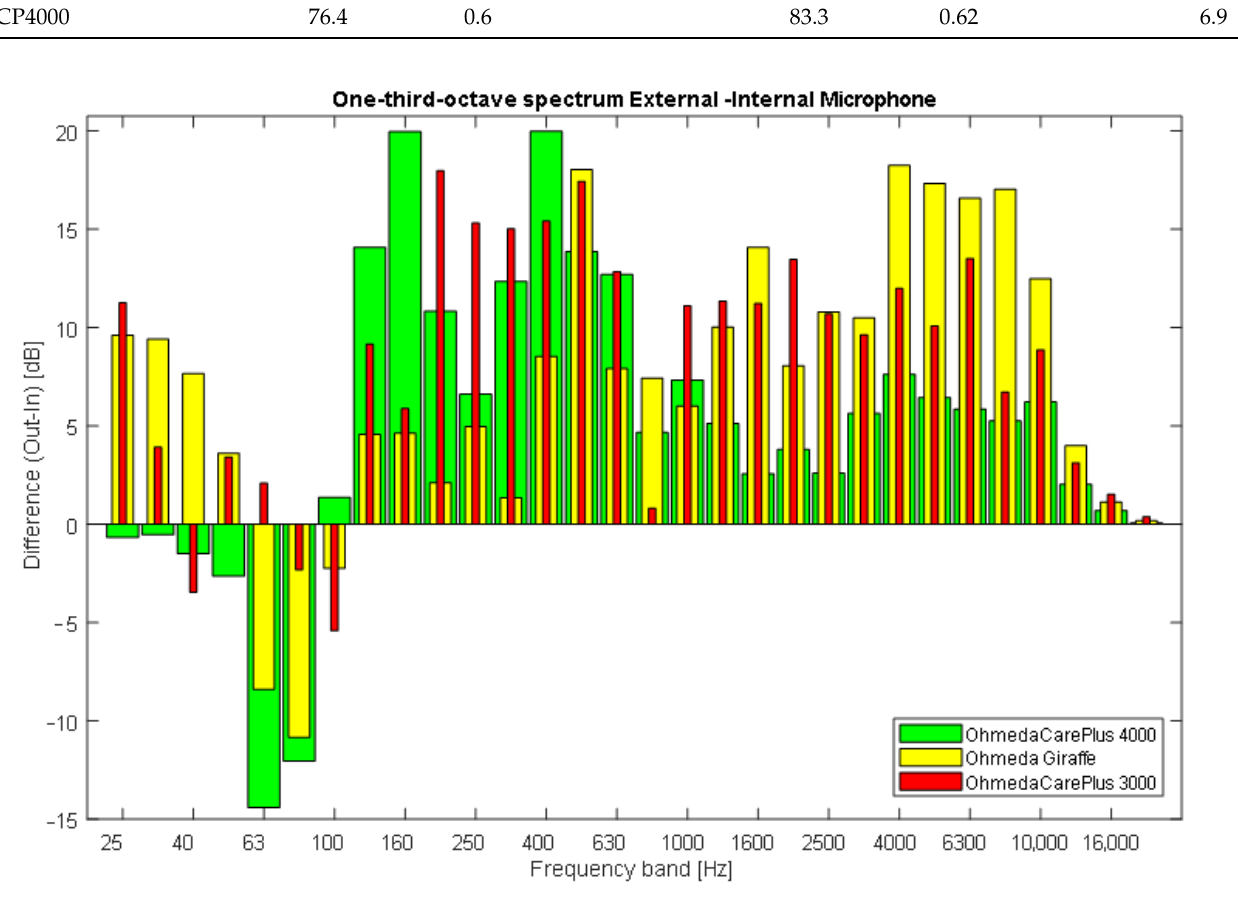
Figure 4. Incubators with an external source noise: spectral difference between outside and inside the incubator (dB).